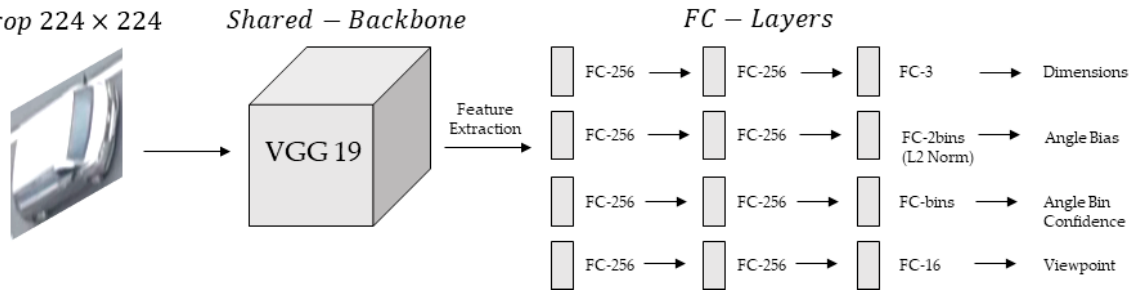
Figure 6. Architecture of the multi-branch network consisting of four branches.